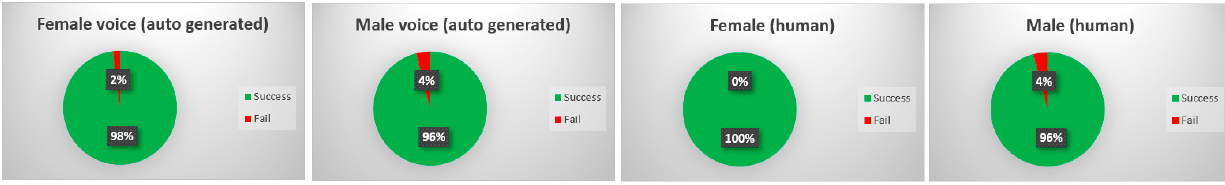
Figure 16. Second round of simulation for failed cases.